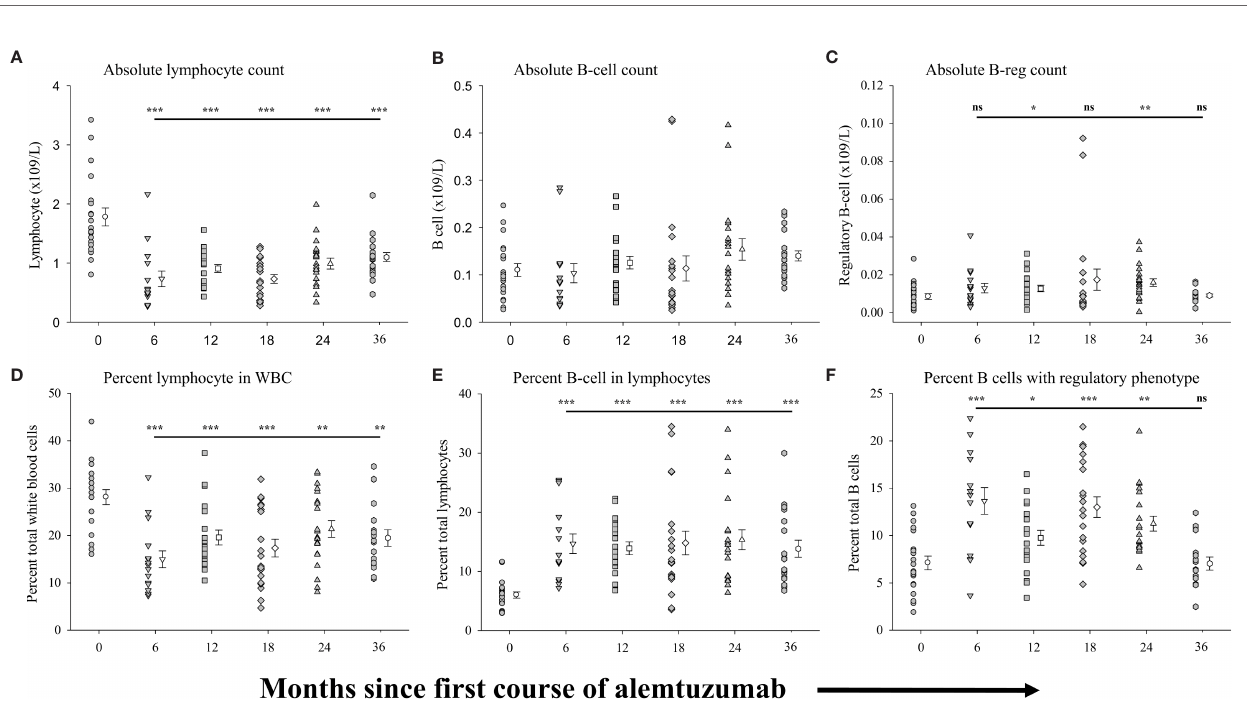
FIGURE 1 | Measures of peripheral blood regulatory B-cells following alemtuzumab treatment: Panels (A – F) illustrate different measures for each treatment cohort (6 month = inverted triangle; 12 month = square; 18 month = diamond; 24 month = triangle; 36 month = hexagon) as compared with a pre-treated patient cohort (circles). Panel (A) shows the absolute number of lymphocytes per liter of blood. Panel (B) shows the absolute number of CD19 + B lymphocytes per liter of blood. Panel (C) shows the absolute number of CD19 + CD20 + CD27 + CD24 hi CD38 hi regulatory B lymphocytes per liter of blood. Panel (D) shows the percent of lymphocytes found in total white blood cells. Panel (E) shows the percent of CD19 + B lymphocytes found within the total lymphocyte population. Panel (F) shows the percent of CD19 + with a CD20 + CD27 + CD24 hi CD38 hi regulatory phenotype. Data for each cohort in each panel shows the individual values for each patient in the cohort ( fi lled circles, fi lled triangles etc.) adjacent to the mean ( ± SEM) for the group as a whole (open circles, open triangles etc.). Signi fi cant changes compared to the pre-treated patient cohort are identi fi ed as *** (p ≤ 0.001), ** (p ≤ 0.01), * (p ≤ 0.05) or ns (not signi fi cant), and are plotted above the corresponding cohort on top of the solid back